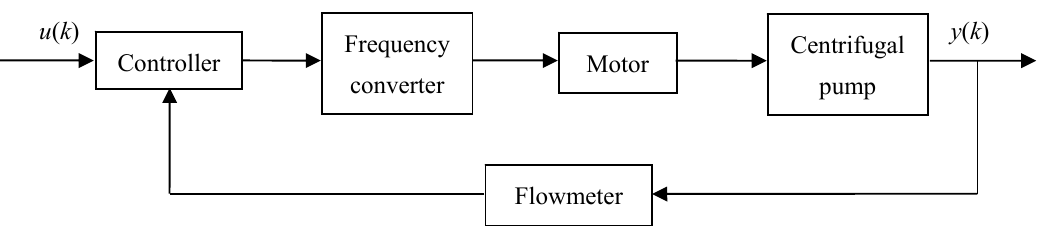
Figure 1. Structure diagram of centrifugal pump flow control system.